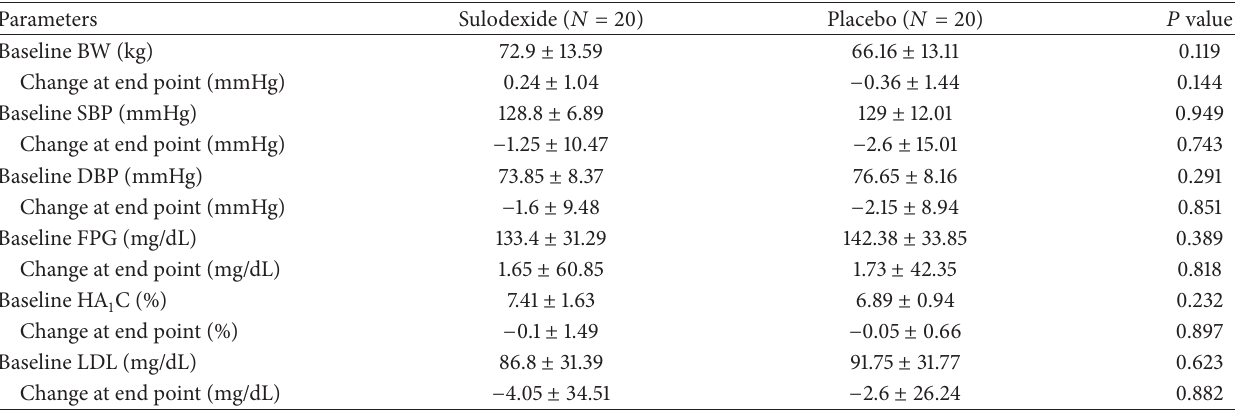
Table 2: Changes from baseline metabolic parameters.